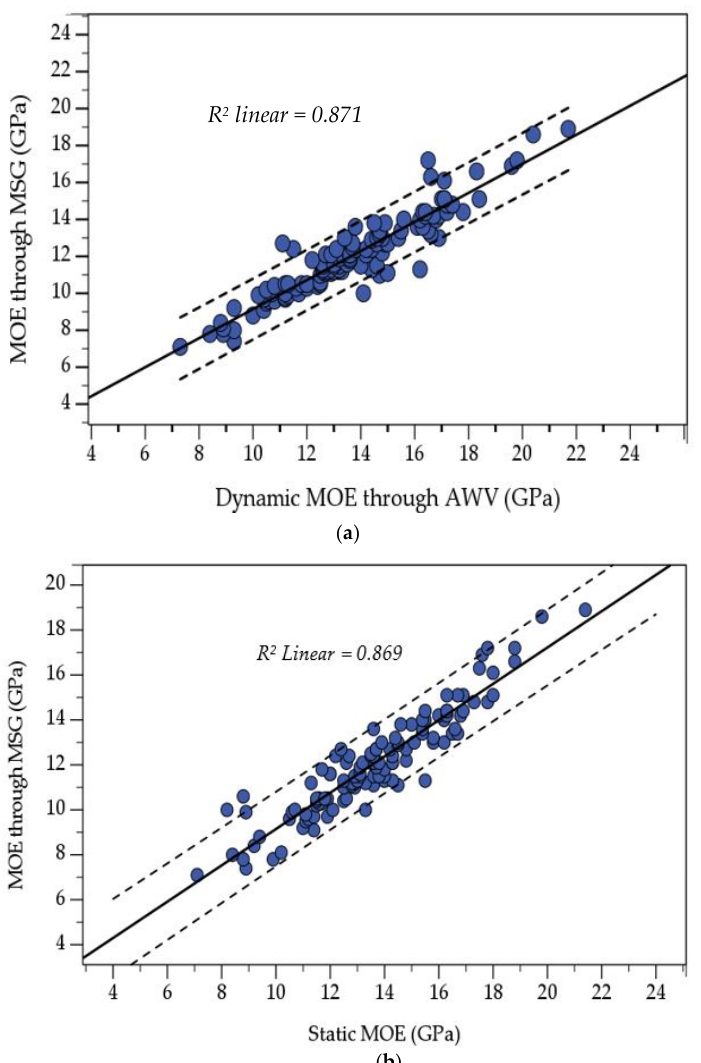
Figure 12. Correlation between the predicted MOE through MSG method and dynamic MOE through NDT ( a ), Correlation between the predicted MOE through MSG method and static MOE ( b ).